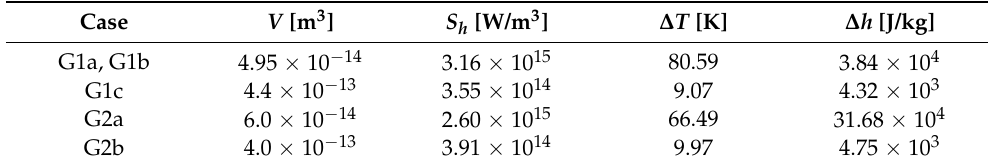
Table 3. Absorption volume V , Source term S h , temperature ∆ T and enthalpy ∆ h rise for single pulse exposure of different WC/SiC MLL